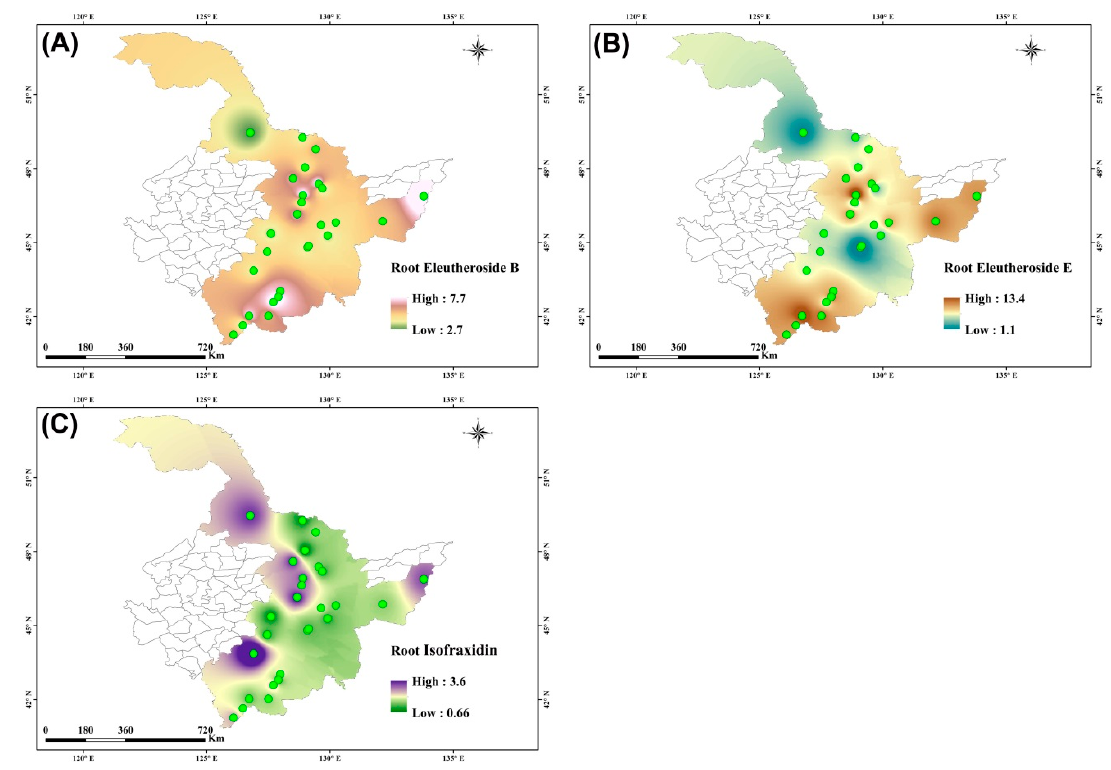
Figure 5. Interpolated mapping of geographical distributions of concentrations of bioactive compounds in underground organs of Eleutherococcus senticosus individuals from populations in Northeast China. ( A ) Geographical distribution of eleutheroside B ( mg g −1 ); ( B ) geographical distribution of eleutheroside E ( mg g −1 ); ( C ) geographical distribution of Isofraxidin ( mg g −1 ). Green dots indicate distribution of plots.